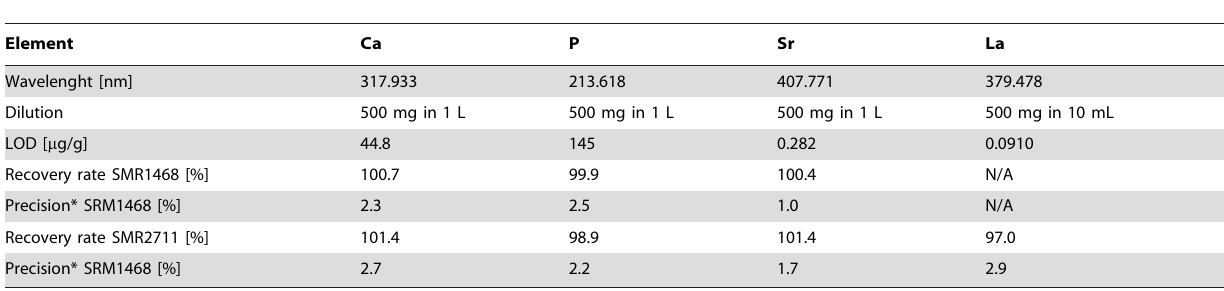
Table 3. Instrumentation characteristics for the ICP-OES measurements.